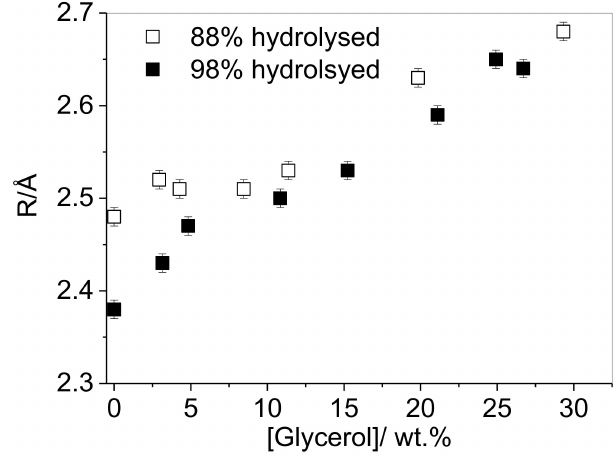
Figure 11. Comparison of the effect of glycerol loading on the cavity radius in solution cast, vacuum-dried PVA resins of different degrees of hydrolysis (open symbols: PVA-50-88, filled symbols